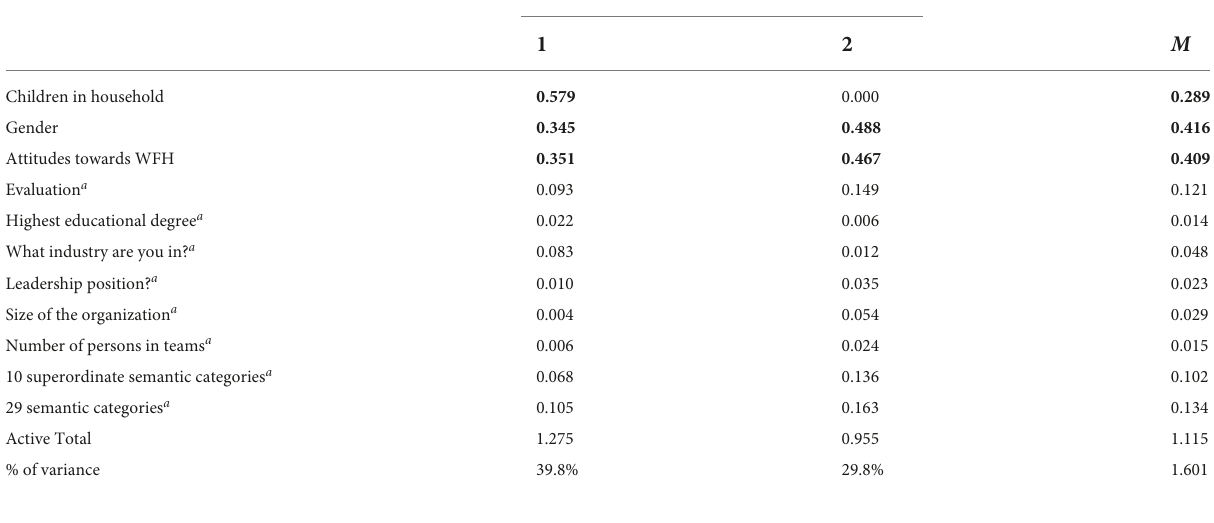
TABLE 4 CATPCA dimension discrimination